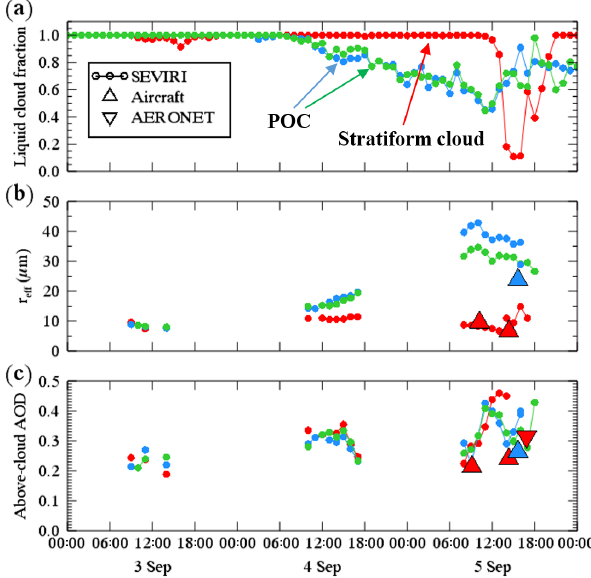
Figure 3. SEVIRI satellite data extracted from a 1 ◦ × 1 ◦ latitude– longitude box around the three trajectories shown in Fig. 2. These are initialised from the position and time of measurements made (i) from the aircraft in the stratiform cloud region downwind of the POC (red), (ii) from the aircraft within the POC (blue) and (iii) from the LASIC site on Ascension Island within the POC (green). Panel (a) shows liquid cloud fraction, (b) shows cloud top effective radius, and (c) shows above-cloud aerosol optical depth. Aircraft data are overlaid in panels (b, c) from measurements made within (upward-pointing blue triangles) and downwind of (upward- pointing red triangles) the POC. Total column aerosol optical depth measurements made downwind of the POC from the AERONET site on Ascension Island are shown with a red downward-pointing triangle in panel (c) . Both the aircraft and AERONET AOD data are interpolated to a wavelength of 550nm from neighbouring channels in order to match that used in the SEVIRI